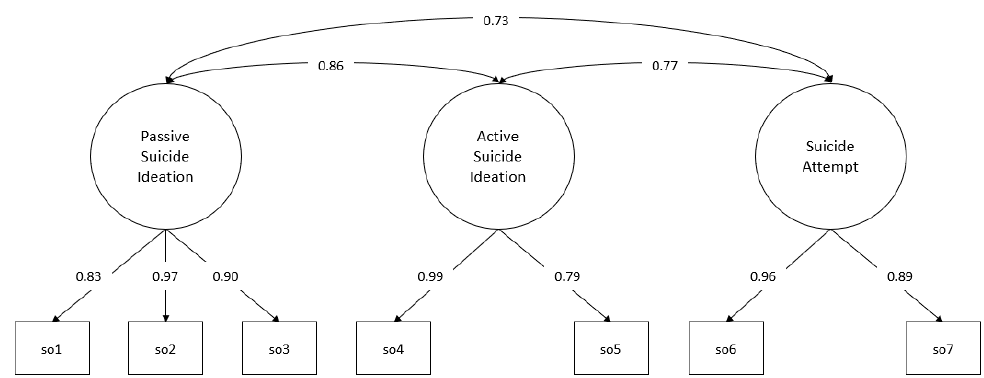
Figure 1. Measurement model: occurrence. so1–so7: suicide severity indicators, items 1 to 7. Standardised factor loadings and interfactor correlations.